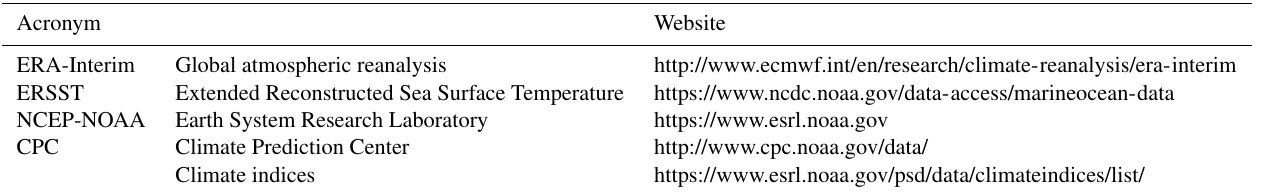
Table 1. Summary of the meteorological and climatological data